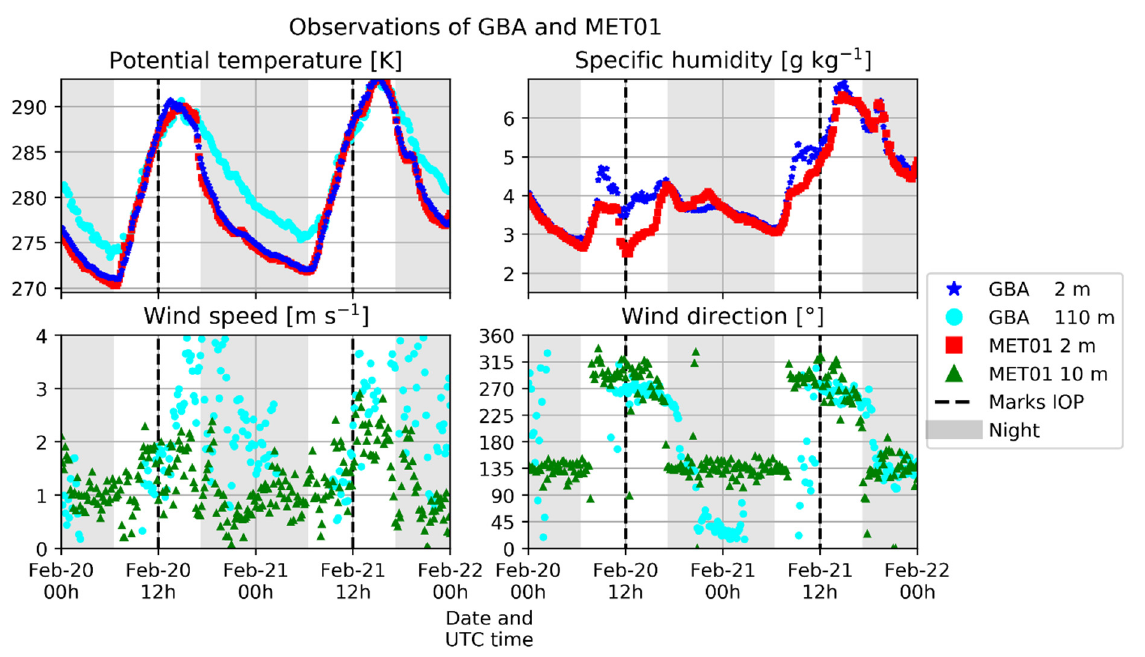
Figure 4. Observations of 20 and 21 February 2017 at the GBA and MET01 stations. The beginning and end of the IOP are indicated by dashed lines. The nighttime periods are shaded.